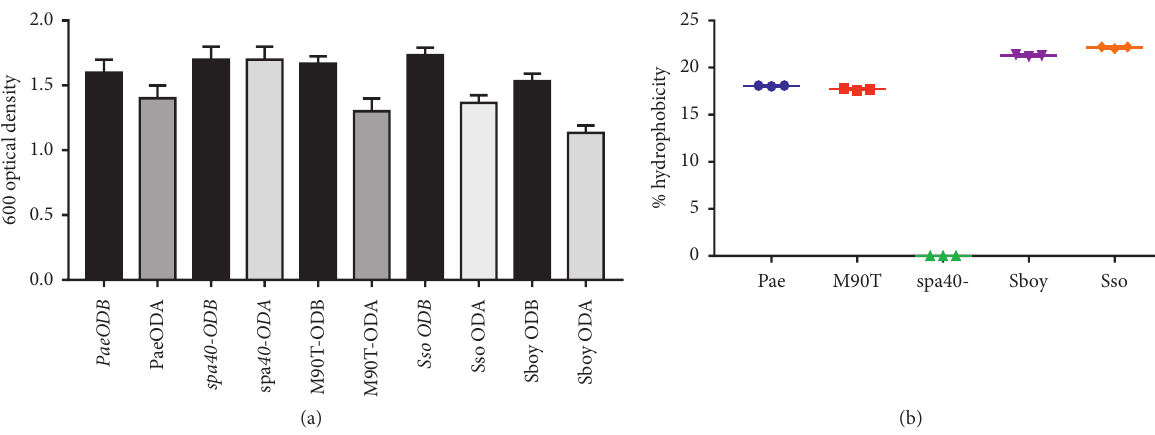
Figure 4: (a) Shigella ’s adhesion to hydrocarbon phase of some strains used in this study. ODB: optical density before vortexing; ODA: optical density after vortexing; M90T: Shigella flexneri 5a strain M90T; Sbo: S. boydii ; Sso: S. sonnei ; spa40-: S. flexneri 5a spa40-; Pae: P. aeruginosa used as positive control. (b) Percentage hydrophobicity of Shigella strains.